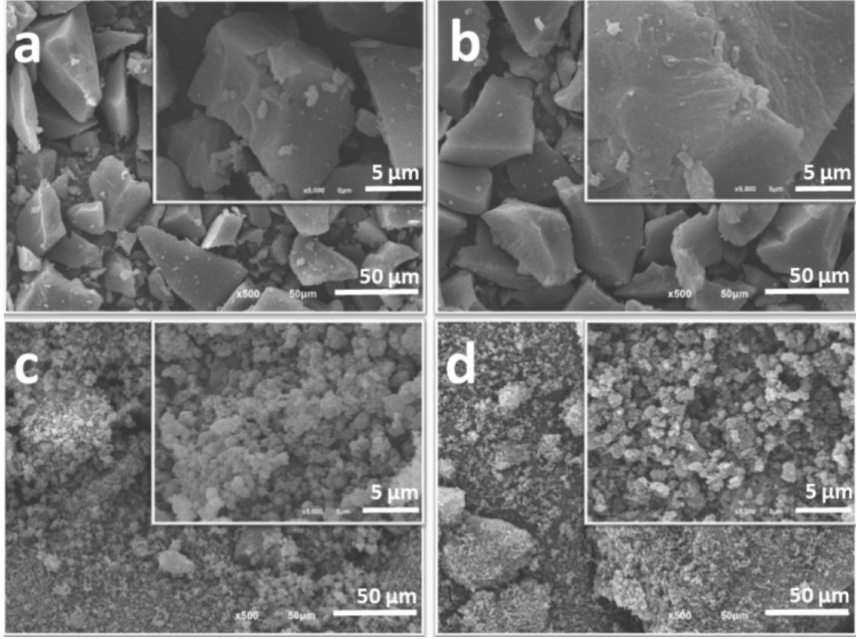
Figure 2. SEM images of activated carbons: ( a ) S13.5st87, ( b ) S12st82, ( c ) S9st80, ( d ) G9st81. Insets show the high magnification image of the carbon surface.